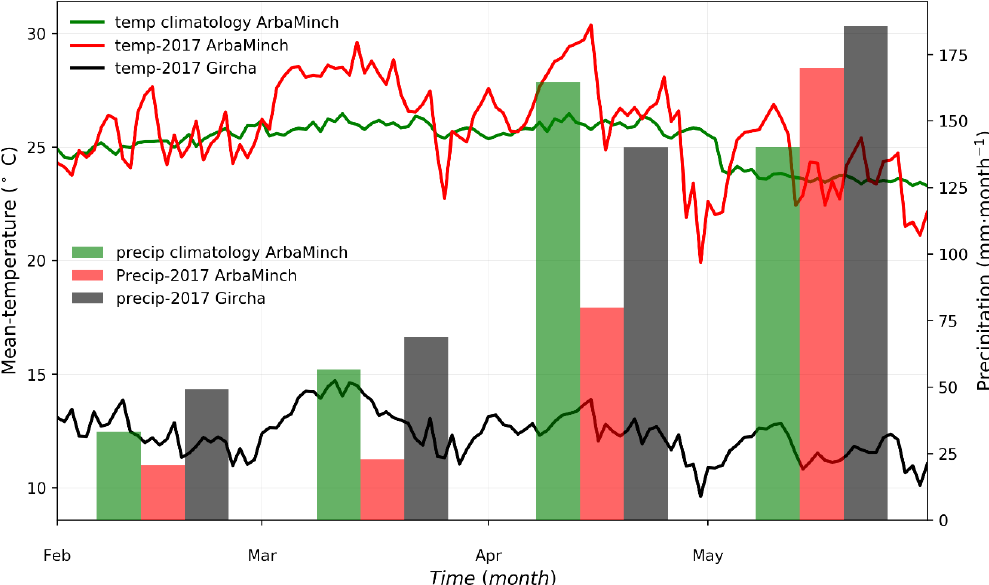
Figure 3. Observed temperature (left y -axis) and total monthly precipitation (right y -axis) during belg 2017 and following the 1987–2016 climatology. The green-colored bars show the climatological belg data from Arba Minch station (data obtained from the NMA, Ethiopia), the red- and black-coloured bars show the 2017 belg season as observed by the GEMS network. The GEMS data were averaged/summed to daily/monthly values,